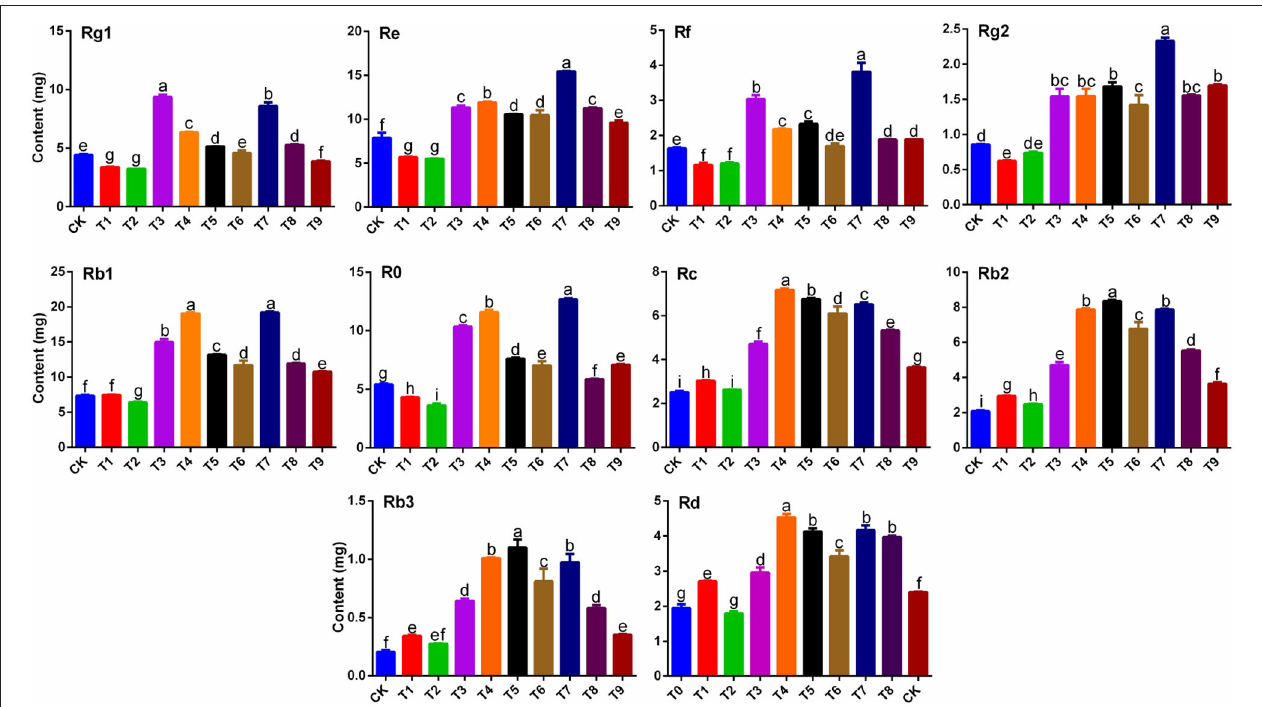
FIGURE 1 | Effects of NPK combined application on contents of ginsenosides Rg1, Re, Rf, Rg2, Rb1, Ro, Rc, Rb2, Rb3, and Rd in ginseng rhizomes ( n = 3). Note: (a) Different letters indicate significant differences among treatments at p < 0.05 according to SNK tests. (b) Composition of fertilization treatments: CK, N 0 P 0 K 0 ;